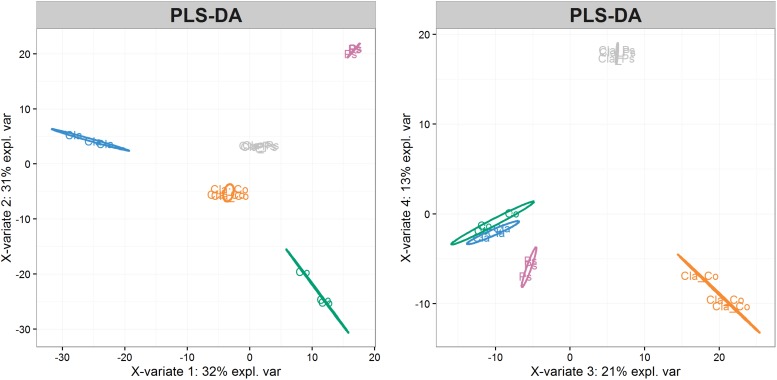
Visualization of samples using the first four latent variables from partial least squares discriminant analysis of 720 selected features. Ps, Pseudoalteromonas monocultures (violet); Co, Cobetia monocultures (green); Cla, Cladosporium monocultures (blue); Cla-Ps, Cladosporium-Pseudoalteromonas co-cultures (gray); Cla-Co, Cladosporium-Cobetia co-cultures (orange). Ellipses represent 95% confidence intervals.